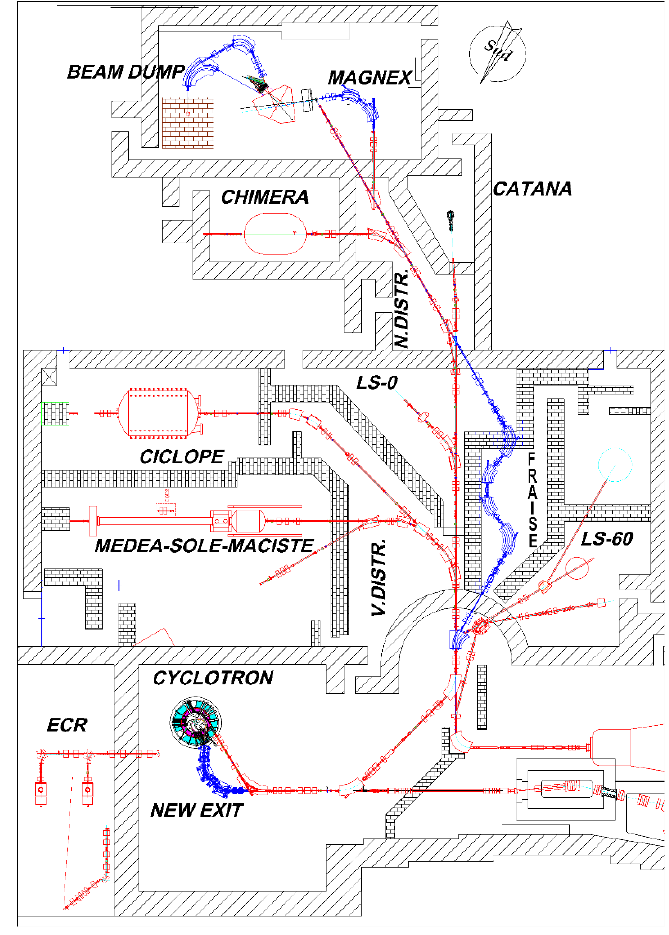
Figure 2. New layout of the LNS. From the CS the beams reach the MAGNEX area through the fragment ion separator (FRAISE) line. The experimental MAGNEX area has to be modified to host a large beam dump.